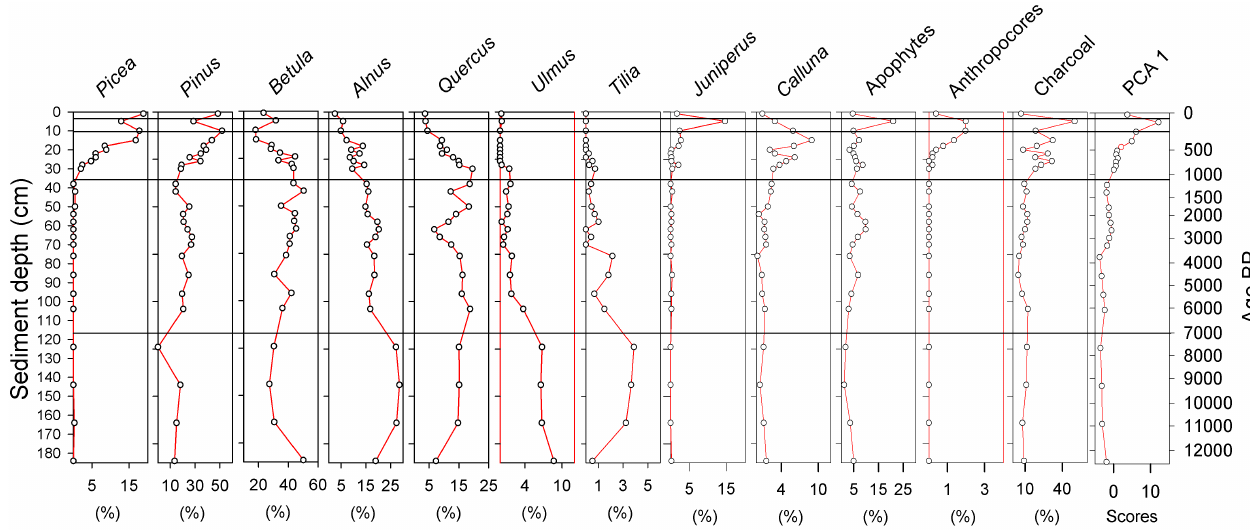
Fig. 3. Percentage diagram of pollen and charcoal from Lysevatten. Frequencies of both pollen and charcoal are expressed as percentages of the total pollen sum at each level. Anthropocores are pollen from cultivated crops and apophytes are pollen types associated with human impact (39, 40, 41). The principal component (PC) 1 summarizes major changes in frequency of all pollen types and charcoal identified in the Lysevatten